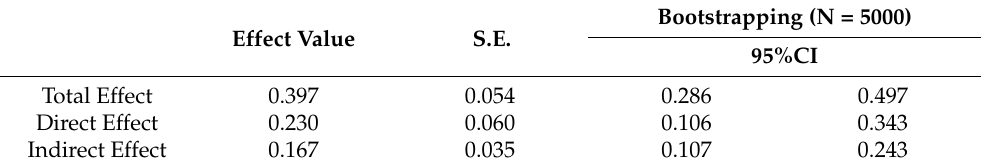
Table 7. Mediation Analysis.